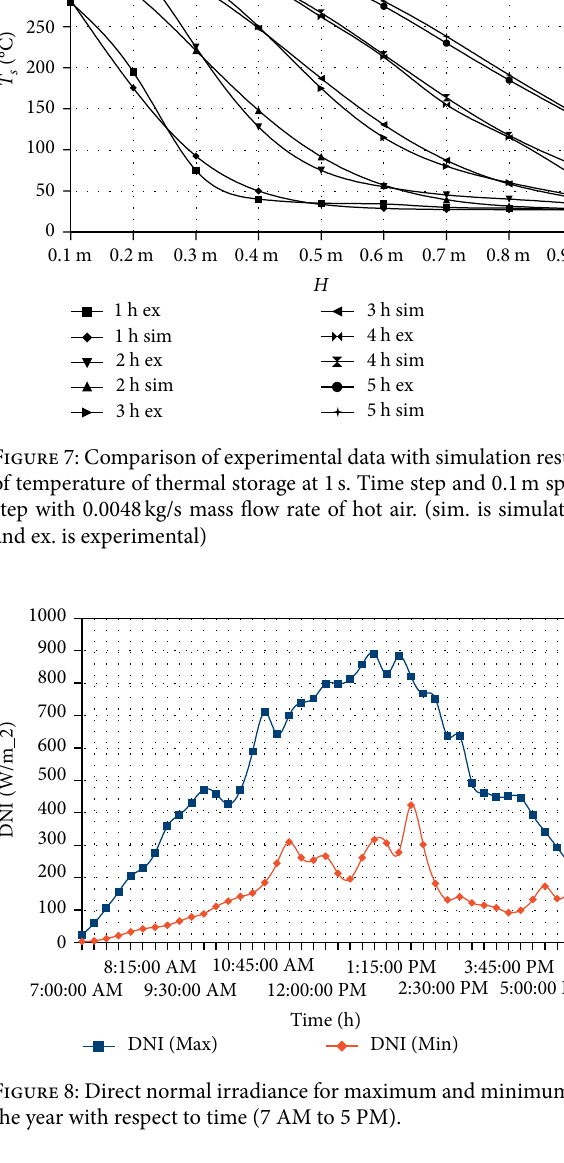
Figure 10: Temperature of air cycling throughout the storage and receiver with respect to charging time from 7 AM to 5 PM for the higher